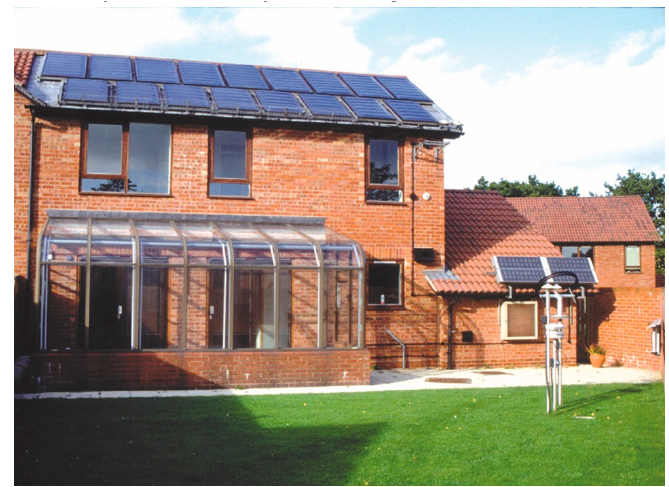
Figure 6. Solar Demonstration House in Bournville, Birmingham (see [3]).